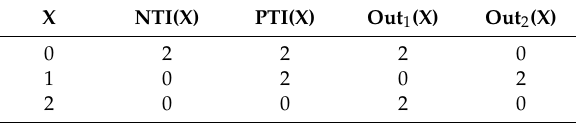
Table 2. Truth Table of Ternary NTI, PTI, Out1, and Out2.